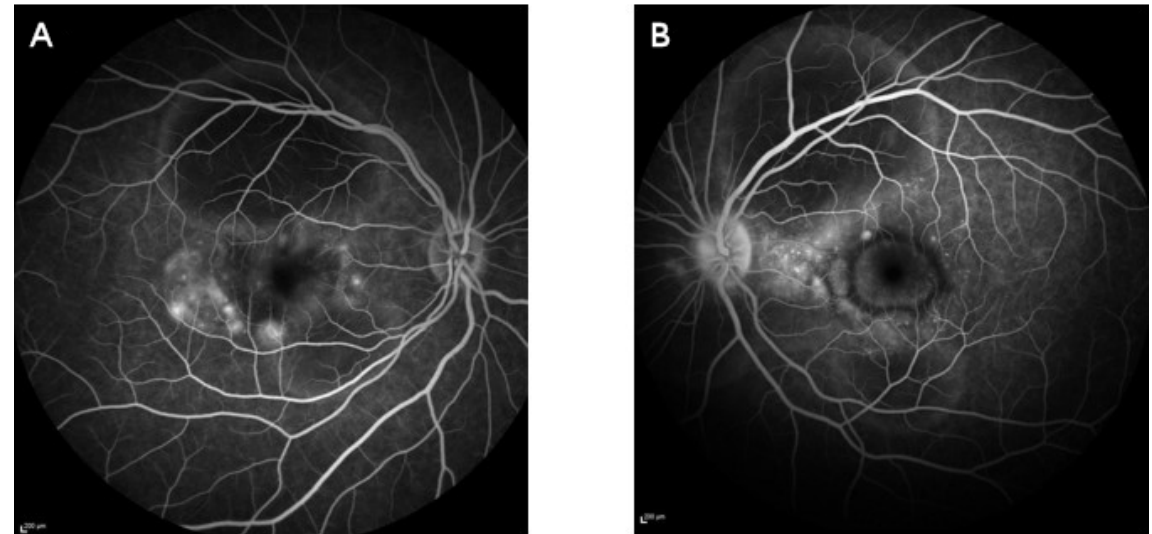
Figure 2: Late-phase fluorescein angiography shows tiny leakage points with limited leakage in the subretinal space (A, B) and discrete staining of the left optic disc